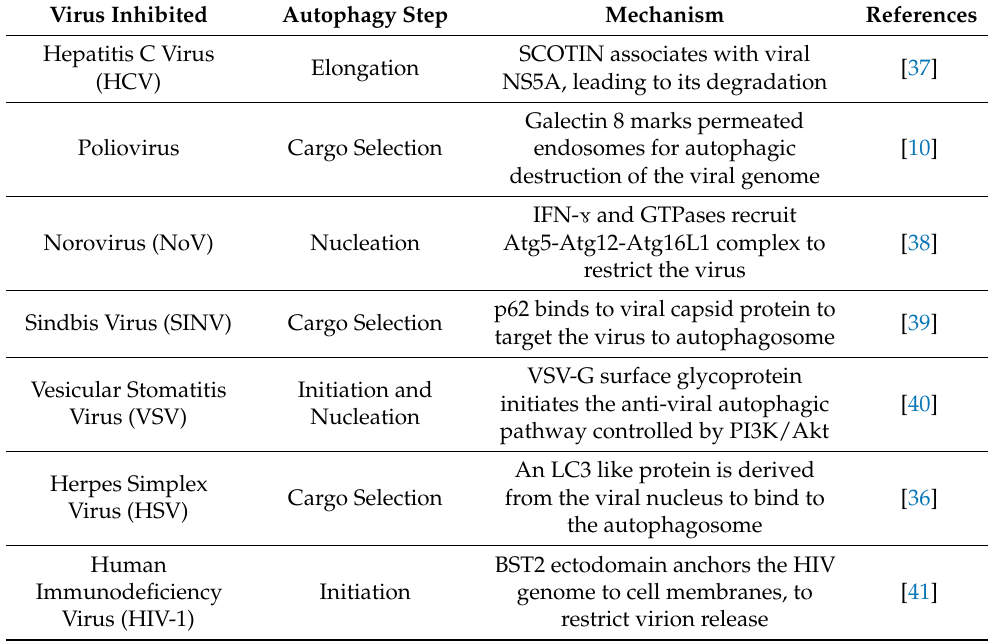
Table 1. Anti-viral action of autophagy against specific viruses. Virus